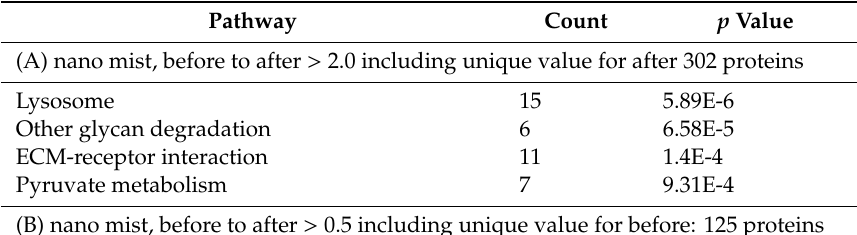
Table 1. List of changed pathway in each group by bathing in a sauna. Pathway Count p